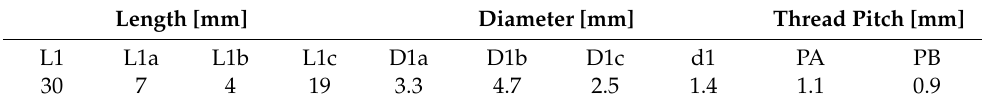
Figure 5. Description of the headless screw dimensions: ( a ) headless screw, ( b ) cross-section of the screw. Table 1. Definition of dimensions, see Figure